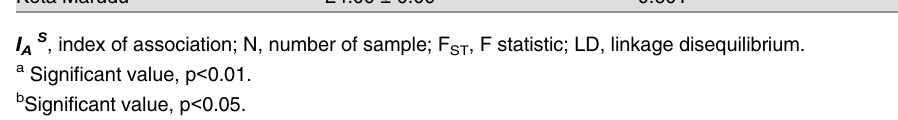
ST , F statistic; LD, linkage disequilibrium.